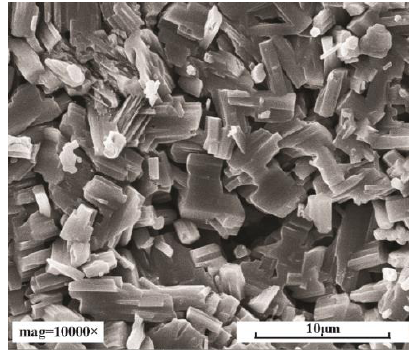
Figure 2. Scanning electron microscopy (SEM) image of lamellar MoO 3.